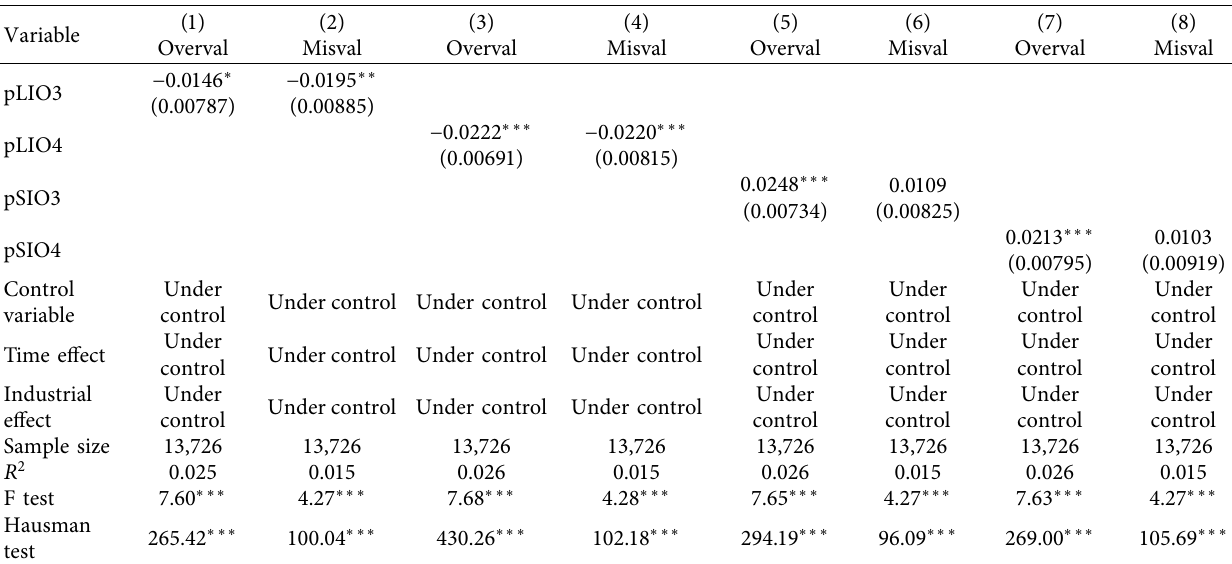
Table 7: Shareholding of long-term and short-term institutional investors and stock mispricing.